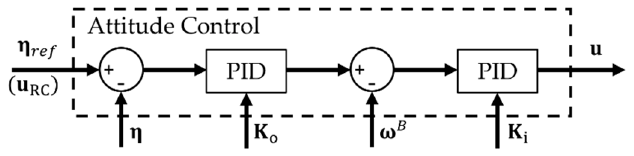
Figure 14. PX4 Control System Block.